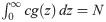
(a, b) Radial cumulative distribution functions (RCDF), g(r), and (c, d) radial distribution functions (RDF), G(r), for density levels on a typical working day. On the left (a, c) for density level 1, with 40-50 pedestrians on the platform, (green domain in Fig 2) and on the right (b, d) for density level 2, with 70-80 pedestrians on the platform (purple domain in Fig 2). Vertical dashed lines at 1.5m, 2.2m and 2.5m indicate, respectively, the Dutch social distancing regulations (r < D), the usable width of the platform (without danger zone) and the critical threshold D′. The solid black line at small r values highlights the ∼r2 growth ratio up to 2.2 m and a blue line for the ∼r1 trend at larger mutual distances. In (b,d) the normalization constant c is chosen such that ∫0∞cg(z)dz=N, where N is the number of people on the platform. Similar plots for a weekend day are reported in Fig 6. We compare the pre-Covid situation with the present, and with a Monte Carlo model of a random distribution of passengers across a region identical to the platform. We report the RDF and RCDF of the current situation including and excluding family-groups contributions, as made possible by the method introduced in Section 5.